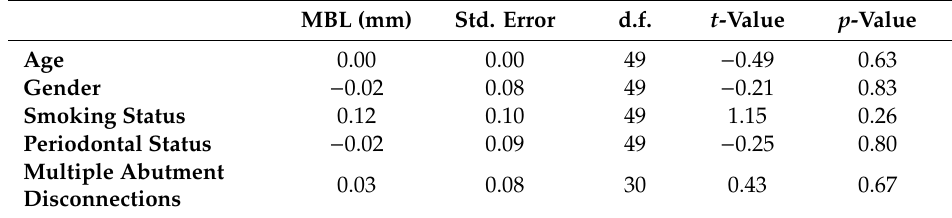
Table 2. Preliminary univariable linear mixed models, analyzing factors possibly influencing marginal bone loss from implant insertion to 12-months after prosthetic loading.